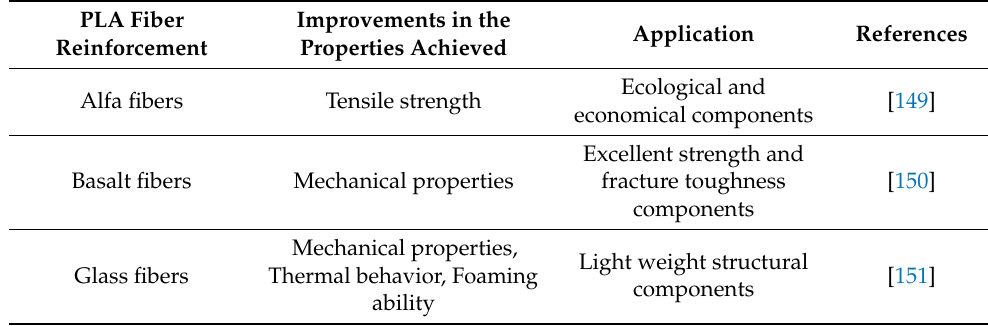
Table 4. Improvements of properties achieved in PLA reinforced with